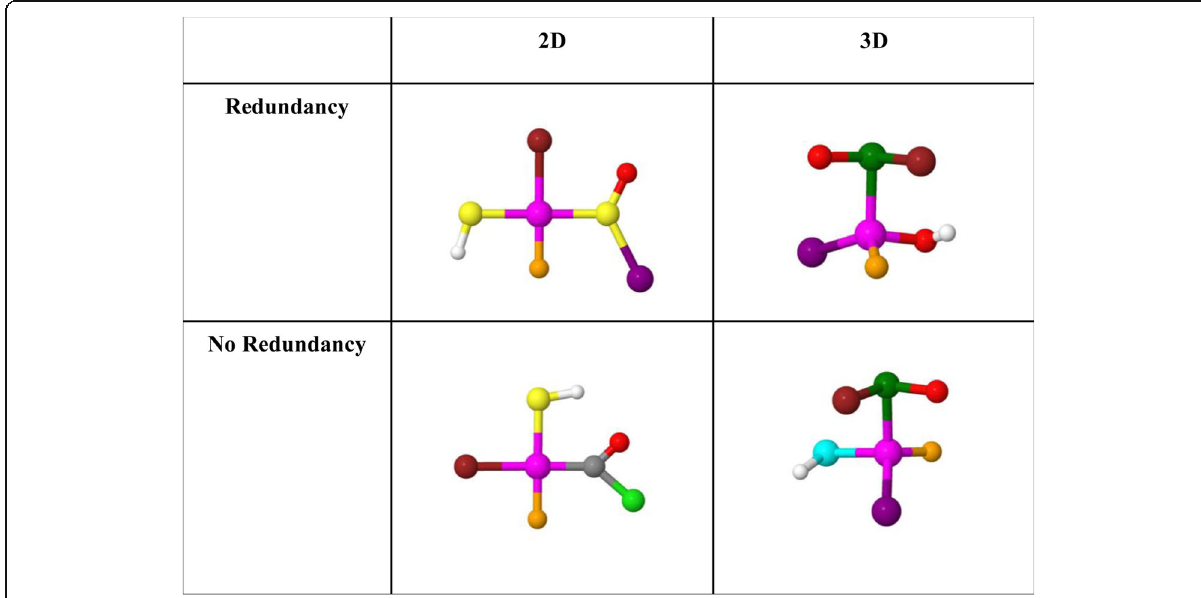
Fig. 5 Examples of 2D and 3D stimuli with and without redundancy. Items with redundancy included two identical colors within the